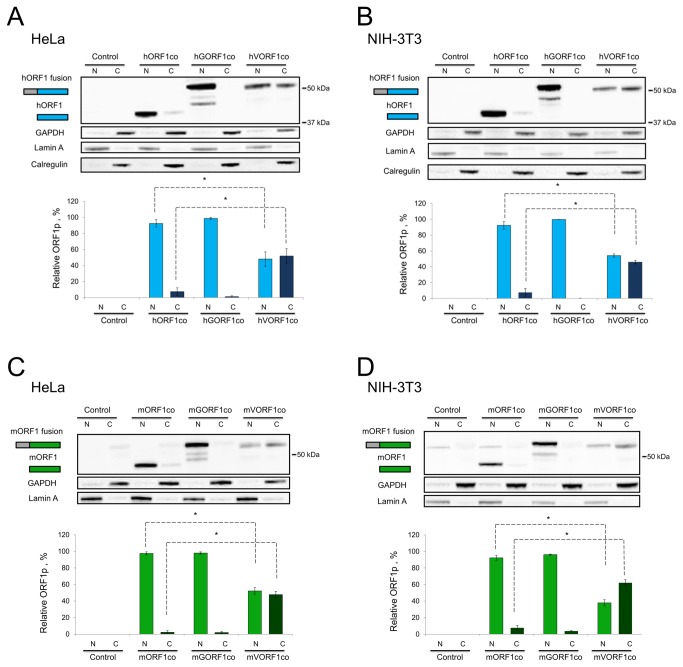
Analysis of subcellular localization of ORF1 protein fusions in human and mouse cells.
A. (top) Western blot analysis of subcellular localization of hORF1co (blue rectangle labeled as hORF1), hGORF1co and hVORF1co (grey/blue rectangle labeled as hORF1 fusion) transiently expressed in HeLa cells. Subcellular localization of the human ORF1 protein detected in nuclear (N) and cytoplasmic (C) fractions with human-specific ORF1p polyclonal antibodies. GAPDH (cytoplasmic marker), Lamin A (nuclear marker), and Calregulin (endoplasmic reticulum marker) proteins are used as loading and cell fractionation controls. Control lanes indicate cells transfected with empty vector. (bottom) Quantitation of western blot results. hORF1 and its fusions were normalized to their respective GAPDH and Lamin A loading controls. The relative nuclear and cytoplasmic ORF1p was calculated as a fraction of the relative total ORF1p detected in respective cell types. B. The same experiment and analysis as in A, but using NIH-3T3 cells. C. Western blot analysis as above using mORF1co (green rectangle labeled as mORF1), mGORF1co or mVORF1co (grey/green rectangle labeled as mORF1 fusion) in HeLa cells. Mouse specific ORF1p polyclonal antibodies were used for protein detection. D. The same experiment and analysis as in C, using NIH-3T3 cells. For all panels, statistically significant data points are indicated by dashed lines. An asterisk represents a significant difference between the subcellular localization of ORF1p and VP16-fused ORF1p (T-test, p-value <0.05).